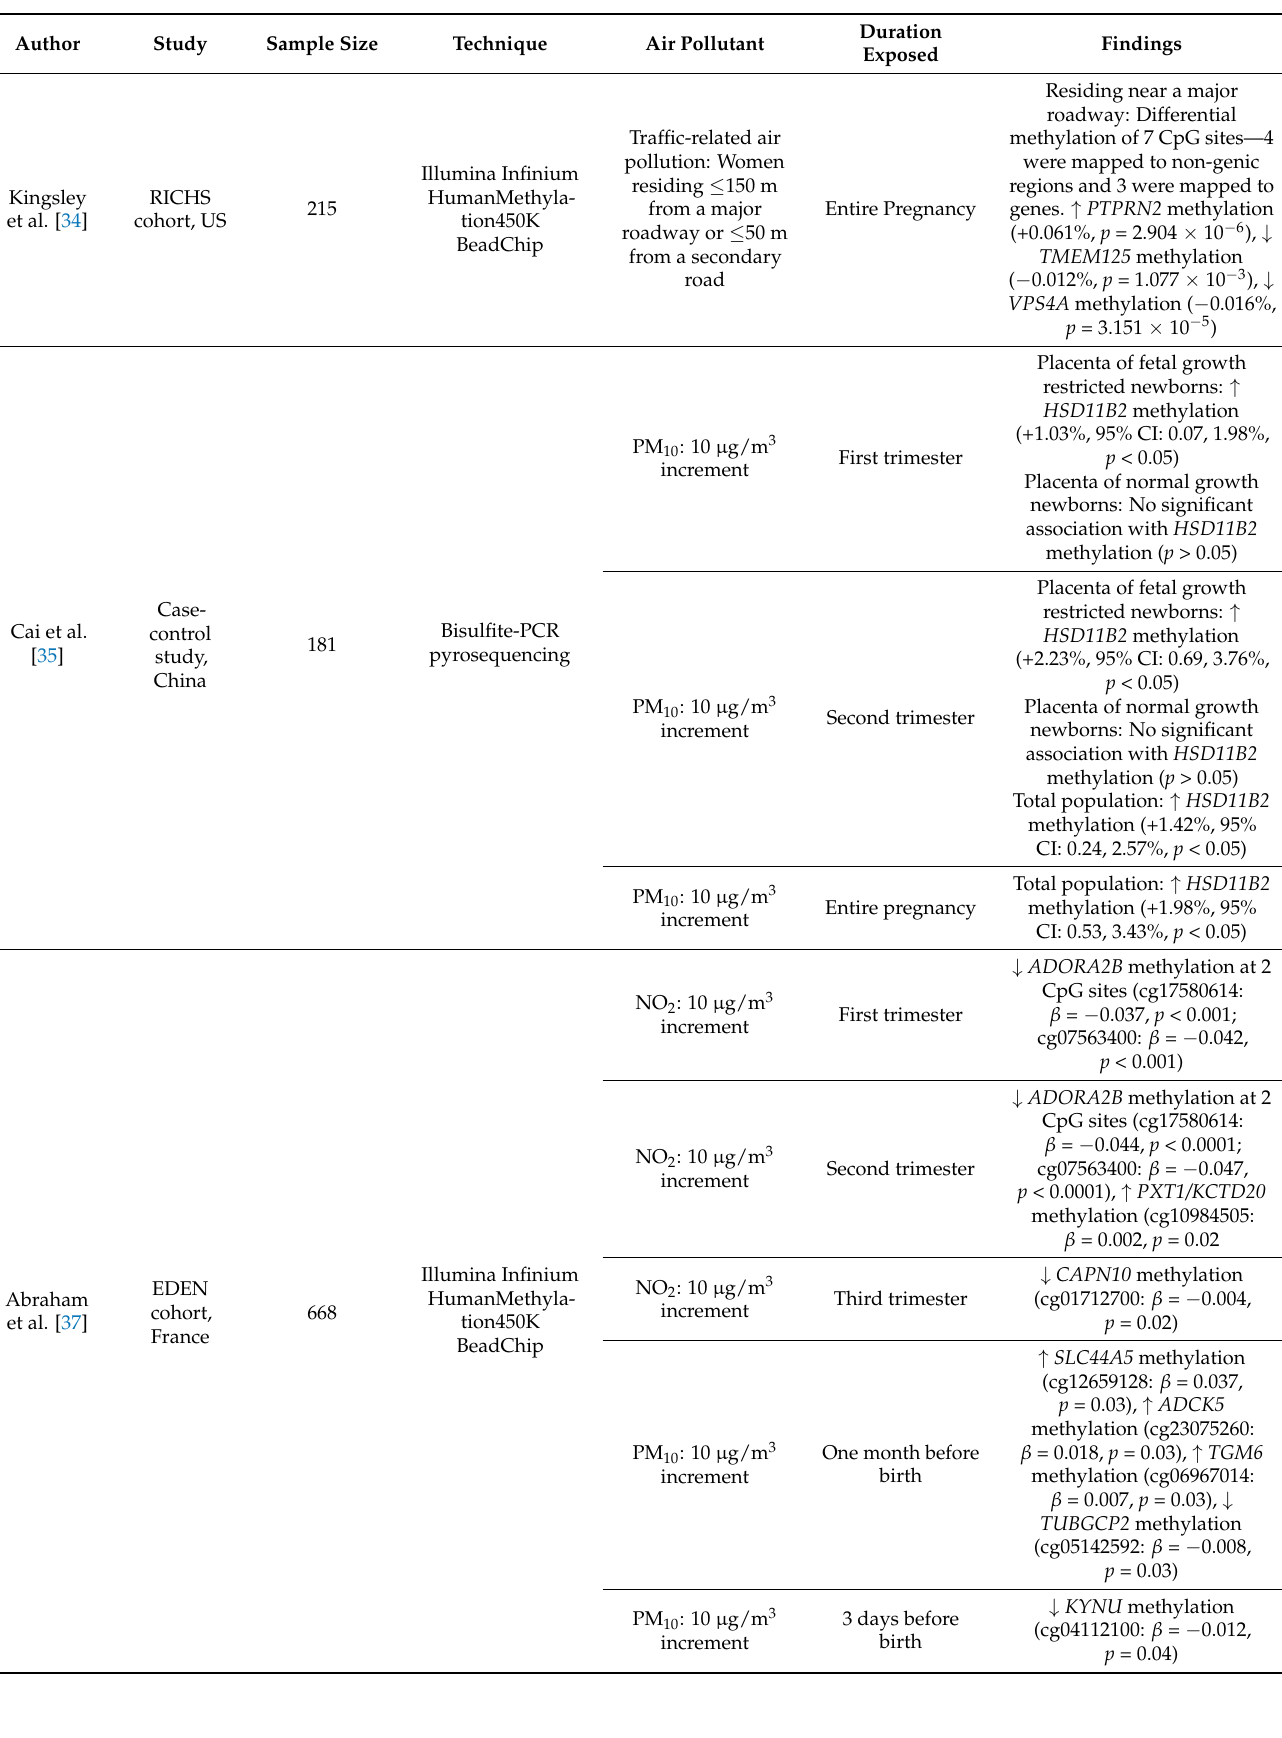
Table 2. Studies on prenatal air pollution exposure and placental candidate gene